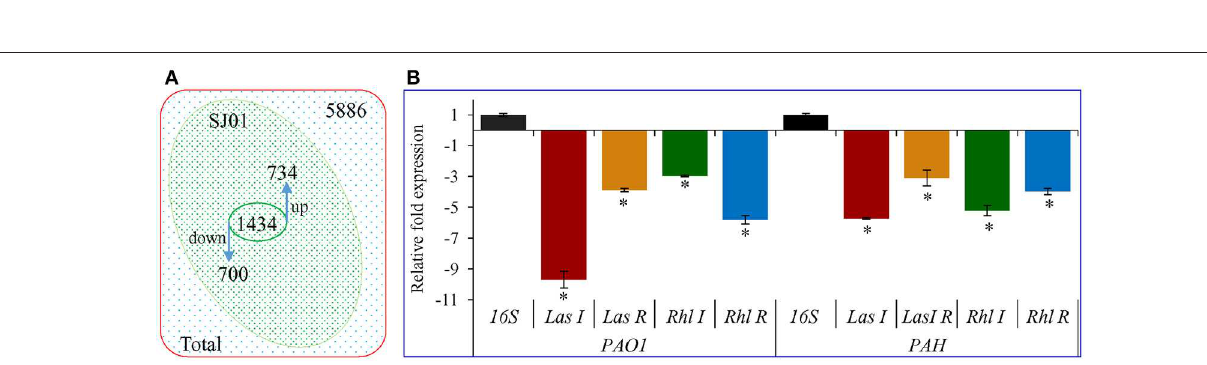
FIGURE 10 | Transcript expression analysis of P. aeruginosa treated with D. tsuruhatensis SJ01 extract. (A) Venn diagram showing genes differentially expressed in P. aeruginosa PAO1 as studied by microarray and (B) expression profiling of some QSI regulatory genes from P. aeruginosa (strains PAO1 and PAH). *Indicates significant differences from the control at P < 0.05